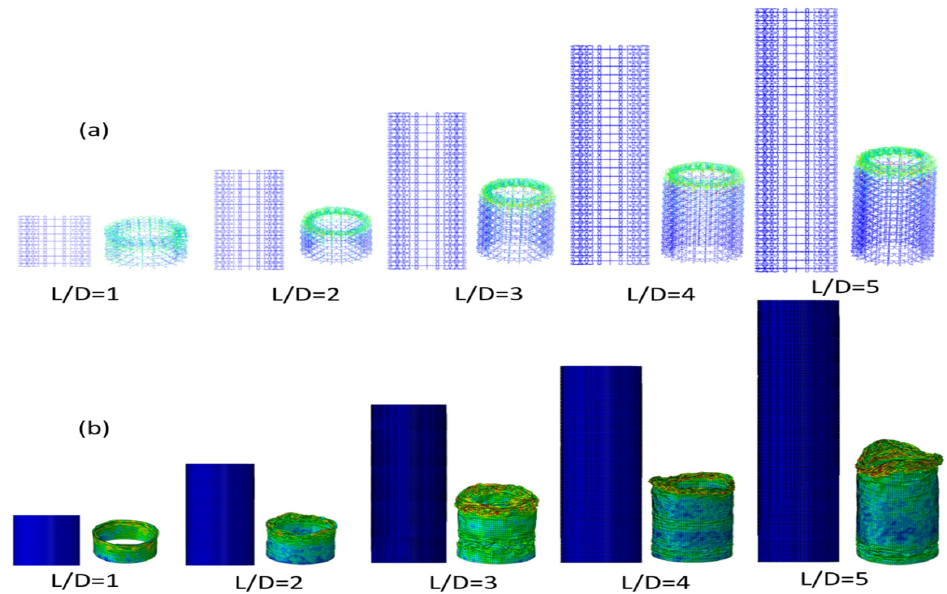
Figure 4. The deformed and unreformed shape of ( a ) cellular tubes and ( b ) conventional tubes with different aspect